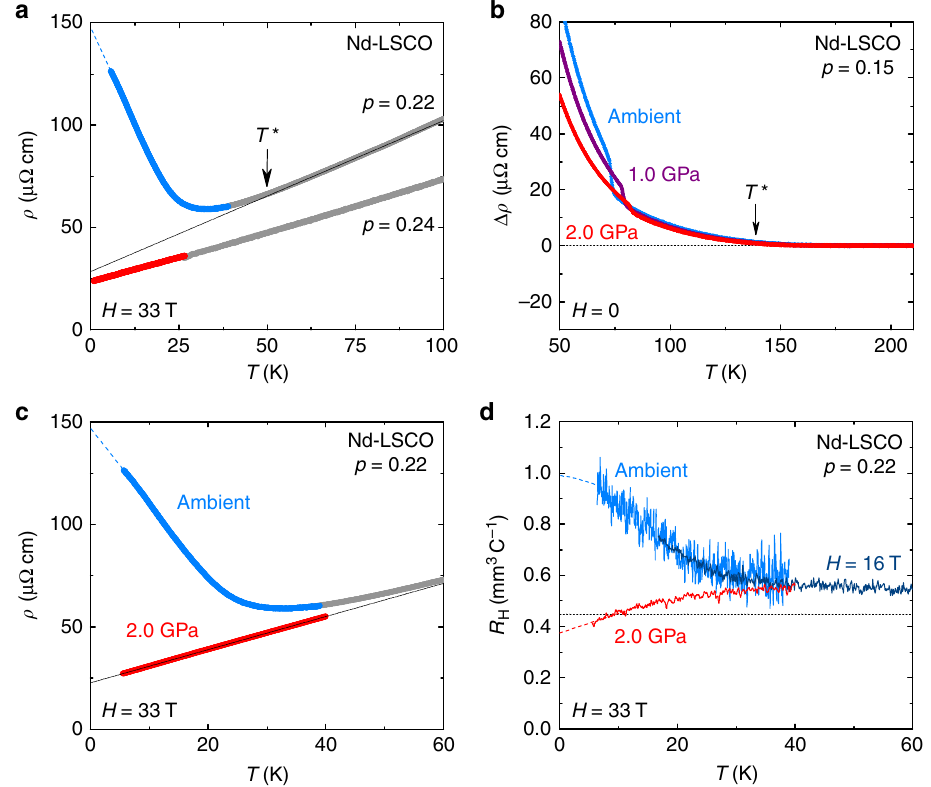
Fig. 2 Effect of pressure on Nd-LSCO. Transport properties of Nd-LSCO as a function of temperature, at different dopings as indicated. In a , c and d , grey data are in zero fi eld and coloured data are in magnetic fi eld. a Resistivity of Nd-LSCO at p = 0.22 from ref. 5 (blue) and at p = 0.24 from ref. 4 (red), in H = 33 T and ambient pressure. At p = 0.22, ρ ( T ) is seen to deviate upwards from its linear T dependence at high T (black line) below the onset temperature T * of the pseudogap phase (Fig. 1a). b Difference between the data and the linear fi ts of Supplementary Fig. 6, showing that the onset of the upturn at T * (arrow) is independent of pressure. The sharp kink is due to the structural transition from orthorhombic at high T (LTO) to tetragonal at low T (LTT) (see Fig. 1). c Resistivity of Nd-LSCO at p = 0.22 and H = 33 T, at ambient pressure (blue, ref. 5) and P = 2.0 GPa (red, this work), with a linear fi t (black line) to the P = 2.0 GPa data. d As in c , but for the Hall coef fi cient R H ( T ). The horizontal dotted line is the value expected from the large hole-like Fermi surface. Coloured dashed lines are a guide to the eye NATURE COMMUNICATIONS | 8: 2044 | DOI: 10.1038/s41467-017-02122-x |